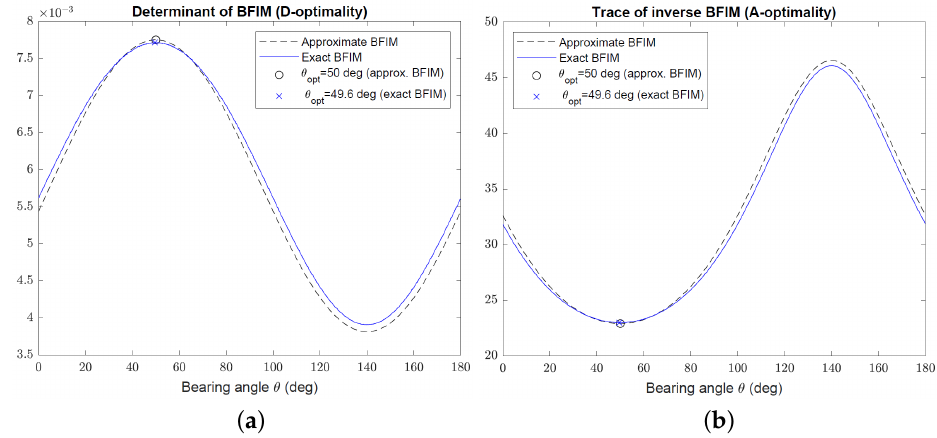
Figure 6. ( a ) Plot of determinant of Φ (D-optimality criterion) versus bearing angle using approxi- mate and exact BFIM. ( b ) Plot of trace of Φ − 1 (A-optimality criterion) versus bearing angle using approximate and exact BFIM.